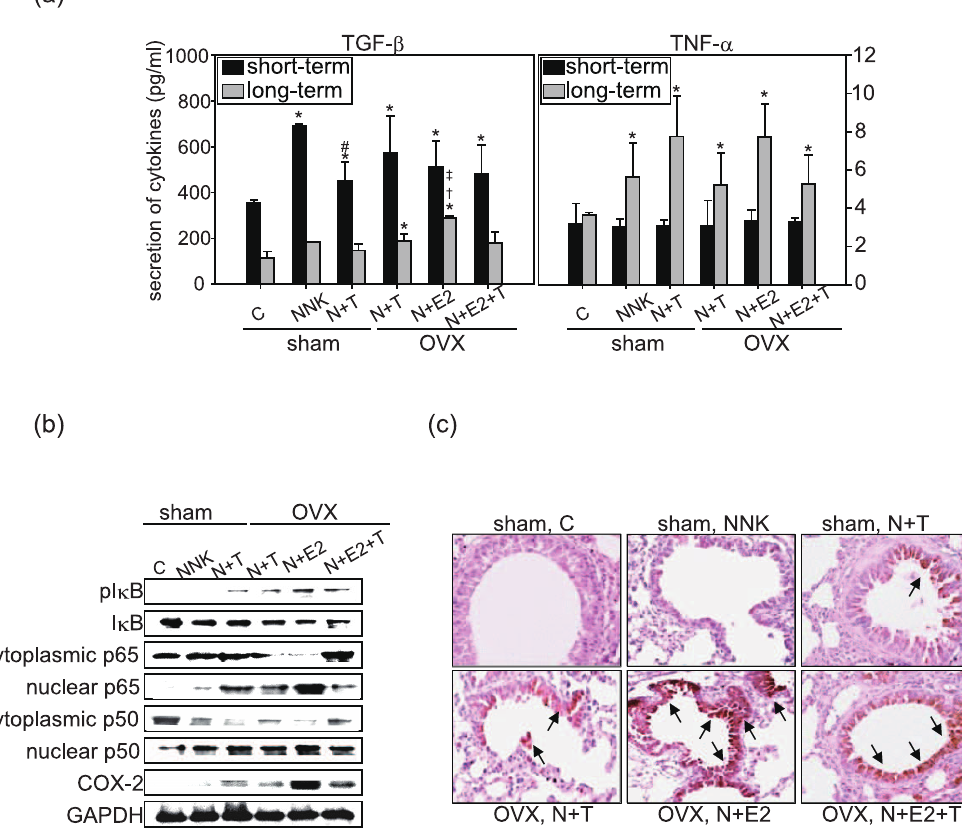
Figure 3. Inflammatory responses in A/J mice. (a) TGF- b (left panel) and TNF- a (right panel) expression in serum by treatment groups. The results are expressed the means 6 SEM (n=3 in each group). * p , 0.05 compared to sham control groups. # p , 0.05 compared to short-term sham NNK groups. { p , 0.05 compared to long-term OVX, N + T groups. ` p , 0.05 compared to long-term OVX, N + E2 + T groups. Short term: experiment terminated at the 7 th week. Long term: experiment terminated at the 24 th week. (b) Lung homogenates were used to detect the expression and activation of pI k B, I k B, cytoplasmic p65, nuclear p65, cytoplasmic p50, nuclear p50, COX-2 and GAPDH by using specific primary antibodies. (c) Immunohistochemistry for COX-2 protein in A/J mice lung tissues. Arrows indicated COX-2 positive stained bronchial epithelium (magnification, 6 100). Sham: sham-operated, OVX: ovariectomized, C: control, N + T: NNK + TCDD, N + E2: NNK + E2 (17 b -estradiol), N + E2 + T: NNK + E2 + TCDD.